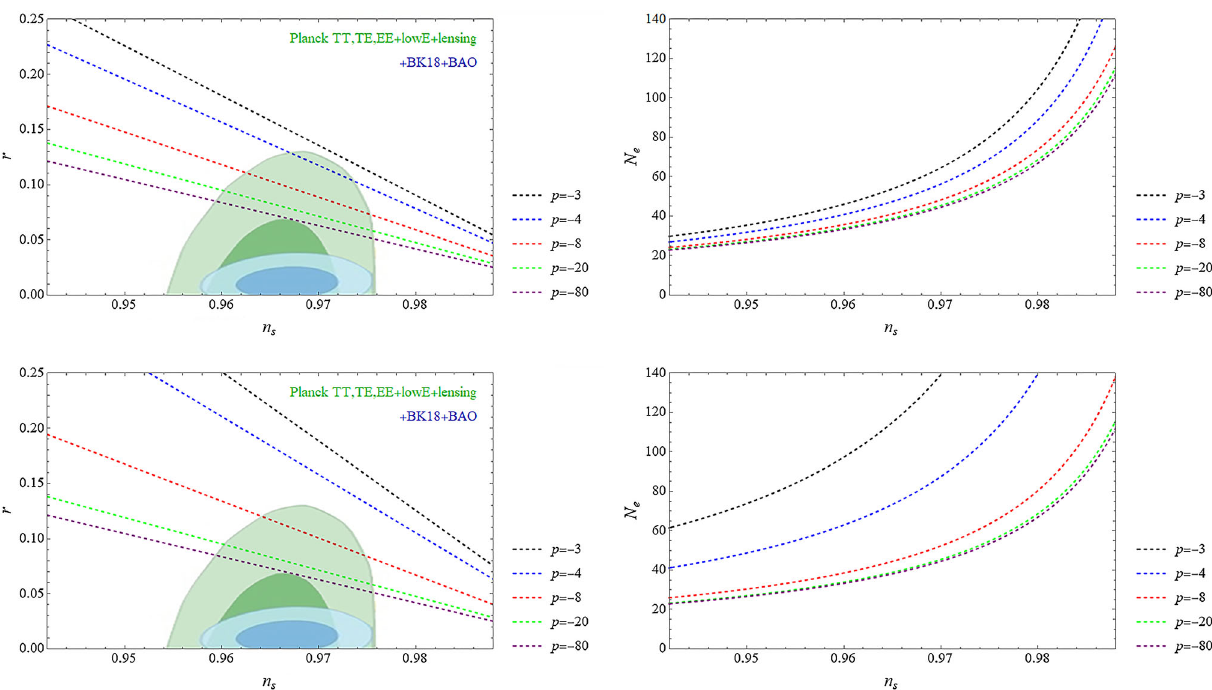
Fig. 3 Plots of r ( n s ) and N e ( n s ) for the exponential potential V 0 e −˜ σ . Here, p < 0 and c = 0 (top plots) and c = 10 (bottom plots). In left plots, green and blue regions are related to the Planck 2018 data [33] and its combination with BK18 and BAO [34], respectively. In addi- tion, the 68% confidence regions are highlighted compared to the 95%